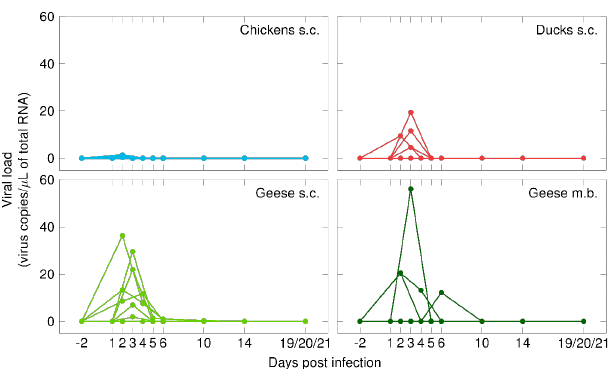
Figure 1. Viremia in chickens (in blue), ducks (in red), and geese (in green) after subcutaneous injection (s.c.) with WNV or the bite of WNV-infected mosquitoes (m.b.). Vaccines 2020 , 8 , x